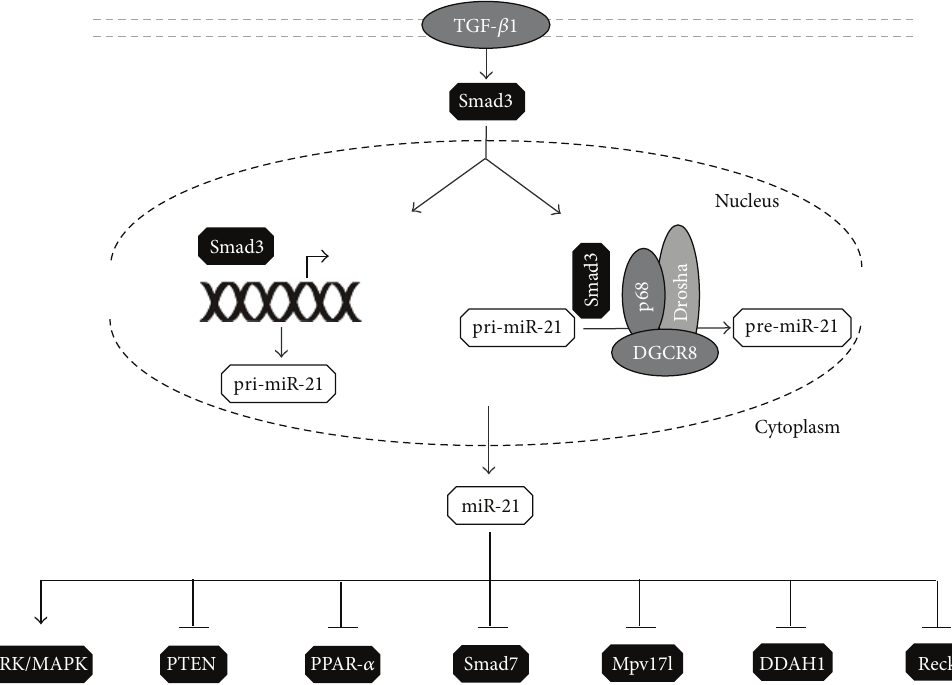
Figure 4: miR-21 regulation and mode of action. Upon activation, Smad3 is translocated into the nucleus, where it can regulate miR-21 expression. It can occur at the transcriptional level through binding to SBE located in the miR-21 promoter or posttranscriptionally through altering Drosha microprocessor complex, which results in increased processing of pri-miR-21 to pre-miR-21. miR-21 contributes to renal fibrosis by alteration of several metabolic pathways and targeting Smad7 protein, a negative regulator of TGF- 𝛽 1/Smad3